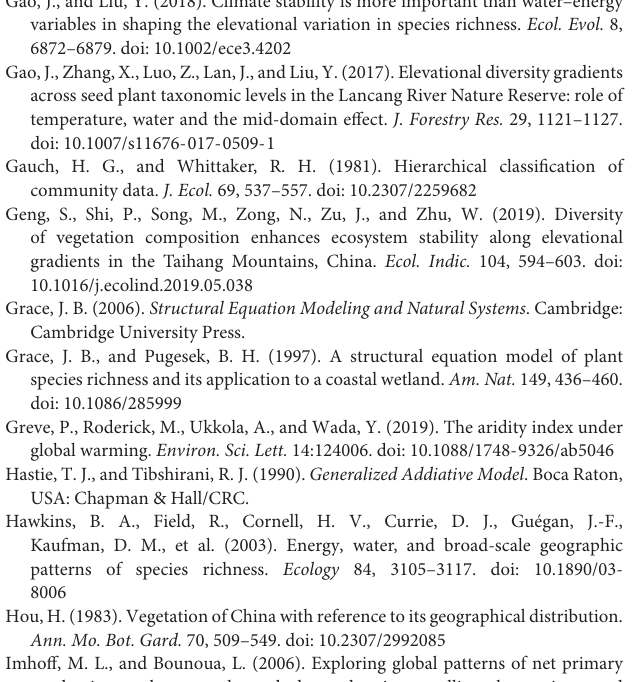
Supplementary Figure 1 | Dendrogram of hierarchical analysis based on gymnosperms species richness and environmental variables along elevation gradients in each ecoregion of China. The separation of ecoregions is based on